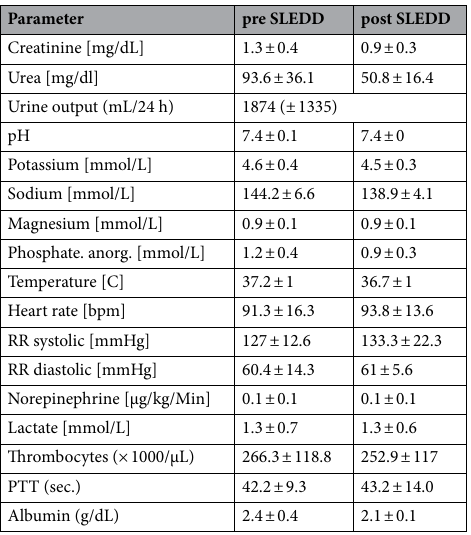
Table 2. Serum chemistry and hemodynamic parameters before and after slow-extended daily dialysis (data from 10 patients, mean ±